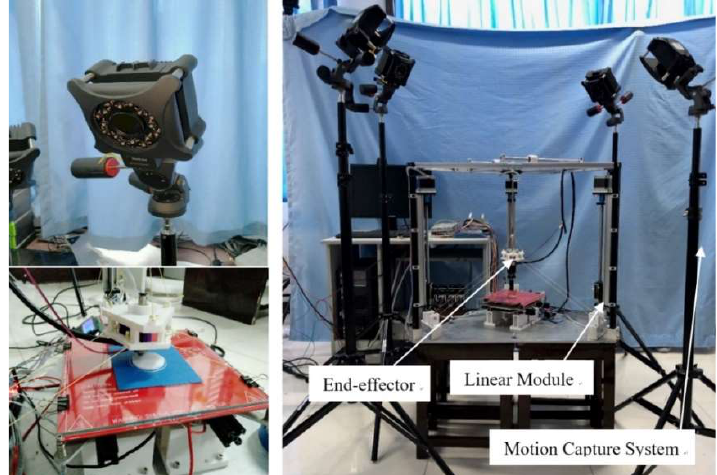
Figure 9. Experimental device of kinematic calibration.